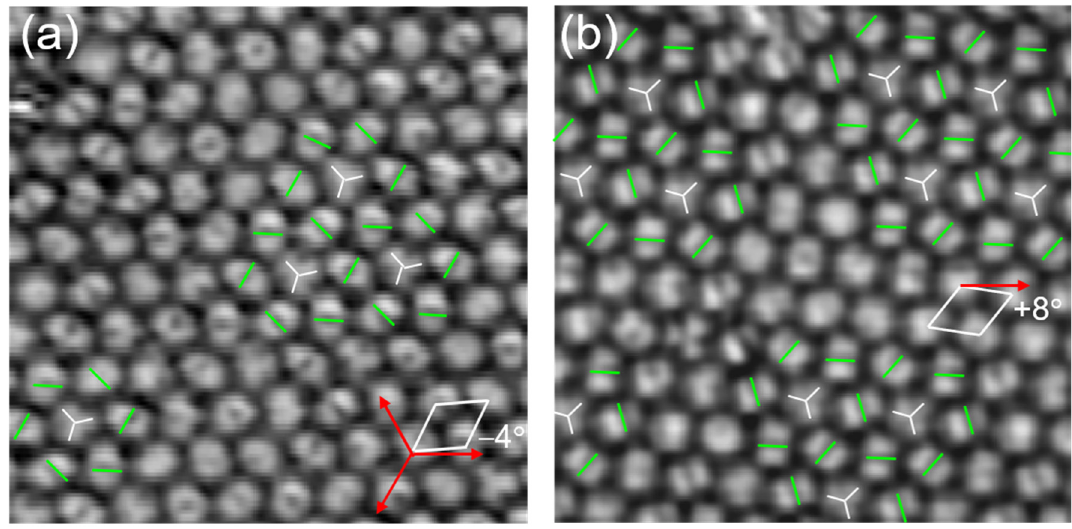
Figure 4. Chiral pinwheel patterns appeared in the R ( − 4 ◦ ) and R ( + 8 ◦ ) domains. ( a ) Seven C 60 molecules with di ff erent directions constitute a chiral pinwheel motif with clockwise handedness in the R ( − 4 ◦ ) domain, 10 nm × 10 nm, 2.0 V, 28 pA. There is a central molecule with three-lobe protrusion. ( b ) Chiral pinwheels with anticlockwise handedness in the R ( + 8 ◦ ) domain, 10 nm × 10 nm, 2.2 V, 22 pA.